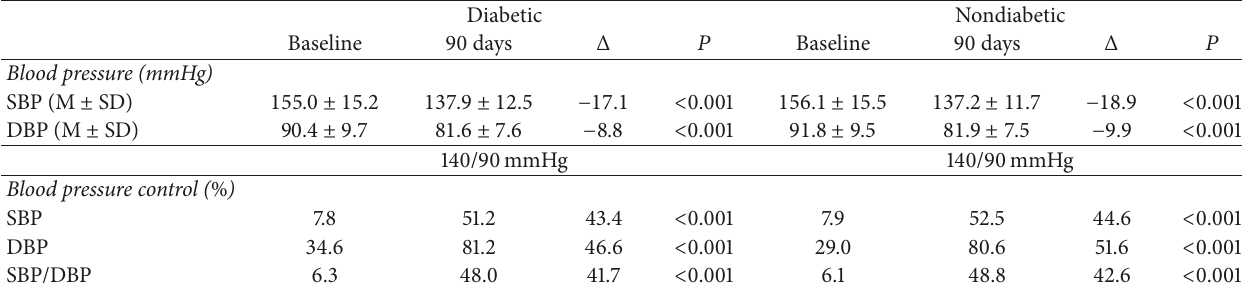
Table 3: SBP and DBP at baseline and 90 days by diabetes status.